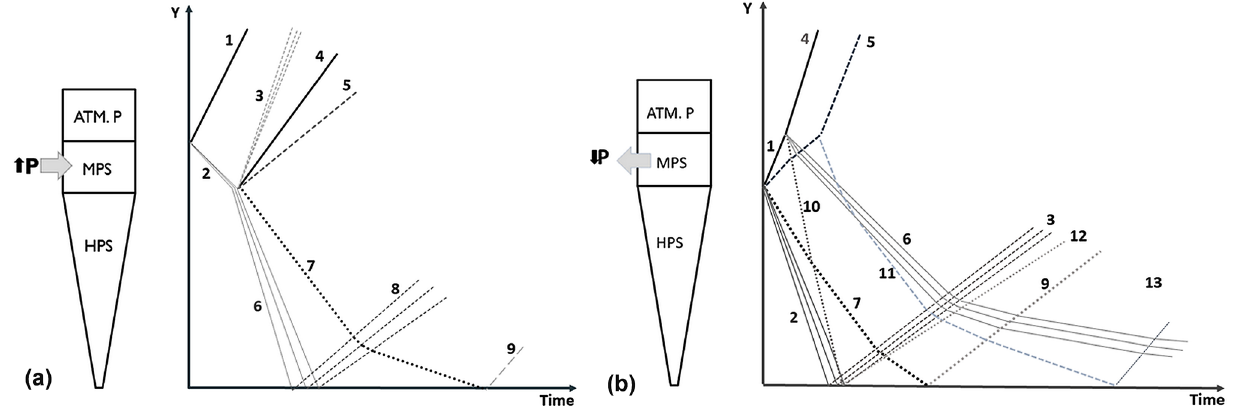
Fig. 3 Illustrative graph of wave patterns in the vertical y-axis of the conical vessel during liquified CO depressurization caused by 2 increasing pressure in the MPS ( a ), and decreasing ( b ) the pressure in the MPS: 1- first shock wave; 2-first rarefaction wave (Fan); 3-first rarefaction wave (fan) reflection; 4-s shock wave; 5-contact surface;